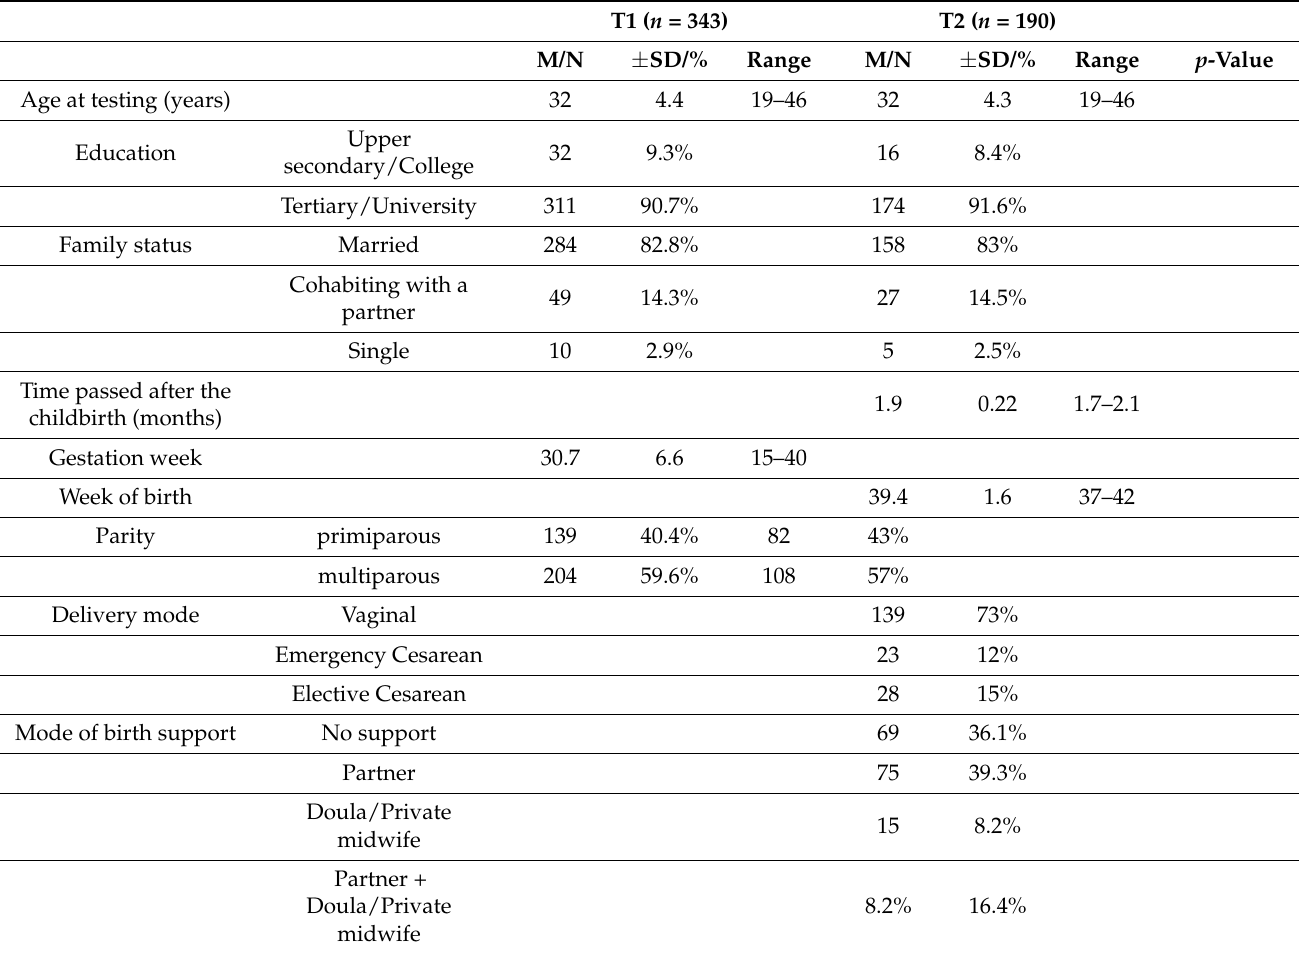
Table 1. Characteristics of the